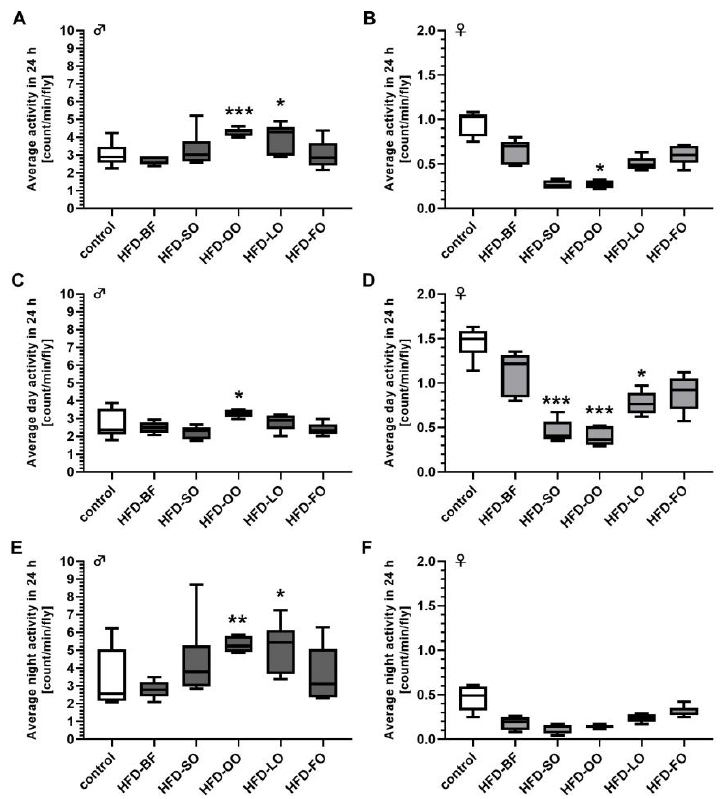
Figure 10. The impact of different high-fat diet (HFD) qualities on the spontaneous locomotor activity of male and female D. melanogaster . D. melanogaster w 1118 flies were fed ad libitum for 3 days with a standard sugar yeast medium (controls) or an HFD comprising 12% ( w / v ) butterfat (BF), sunflower